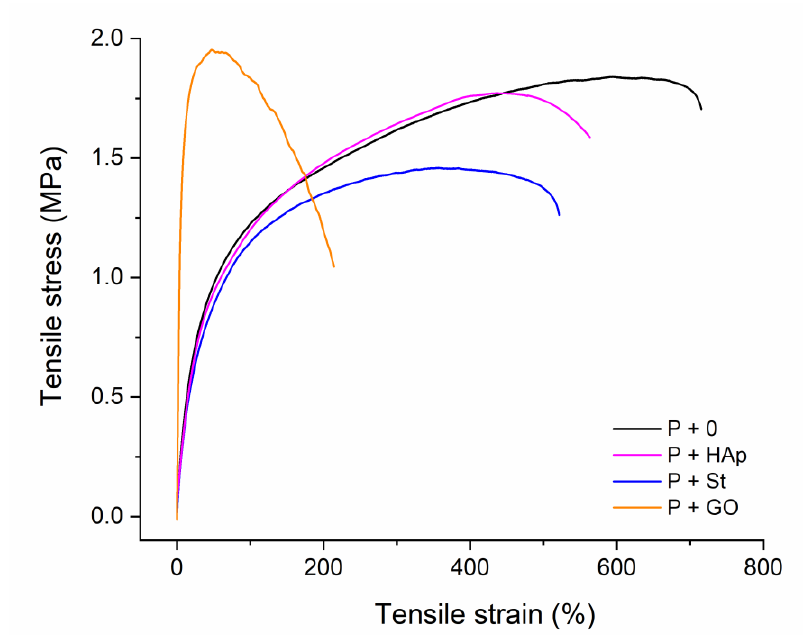
Figure 6. Stress-strain curves of the PUU film and nanocomposite films with starch, graphene oxide and hydroxyapatite.